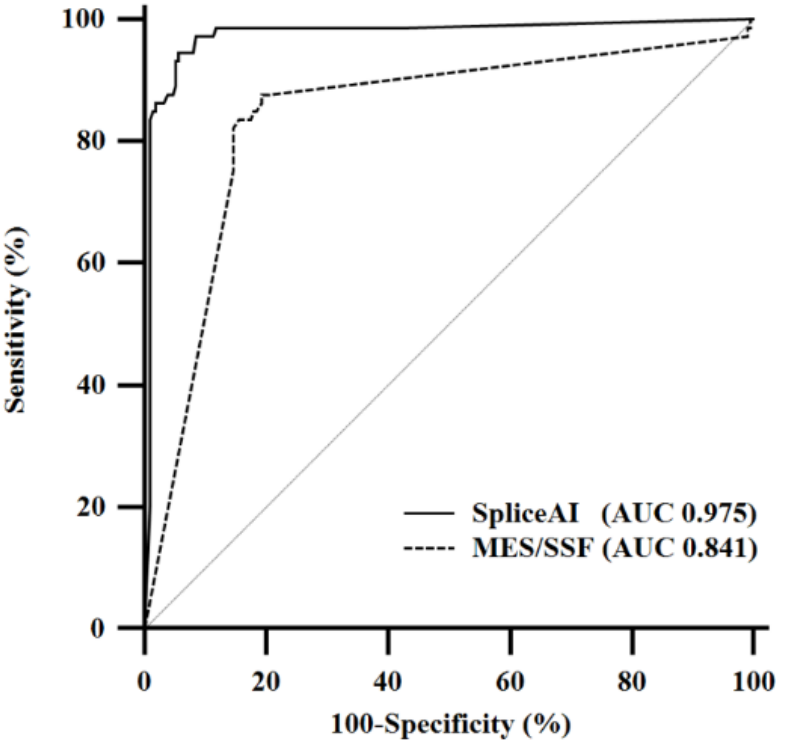
Figure 2. Receiver operating characteristic curves and an area under the receiver operating charac- teristic curve comparing SpliceAI and MES/SSF for predicting the splice effect of 285 NF1 variants.